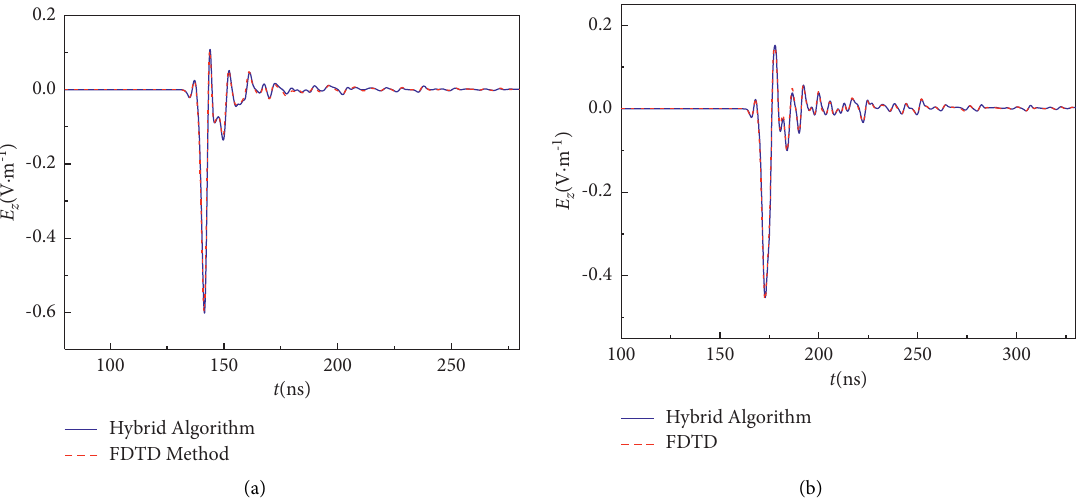
Figure 6: Near-field E z scattered from the rough surface by FDTD and by hybrid algorithms for the TM case. (a)